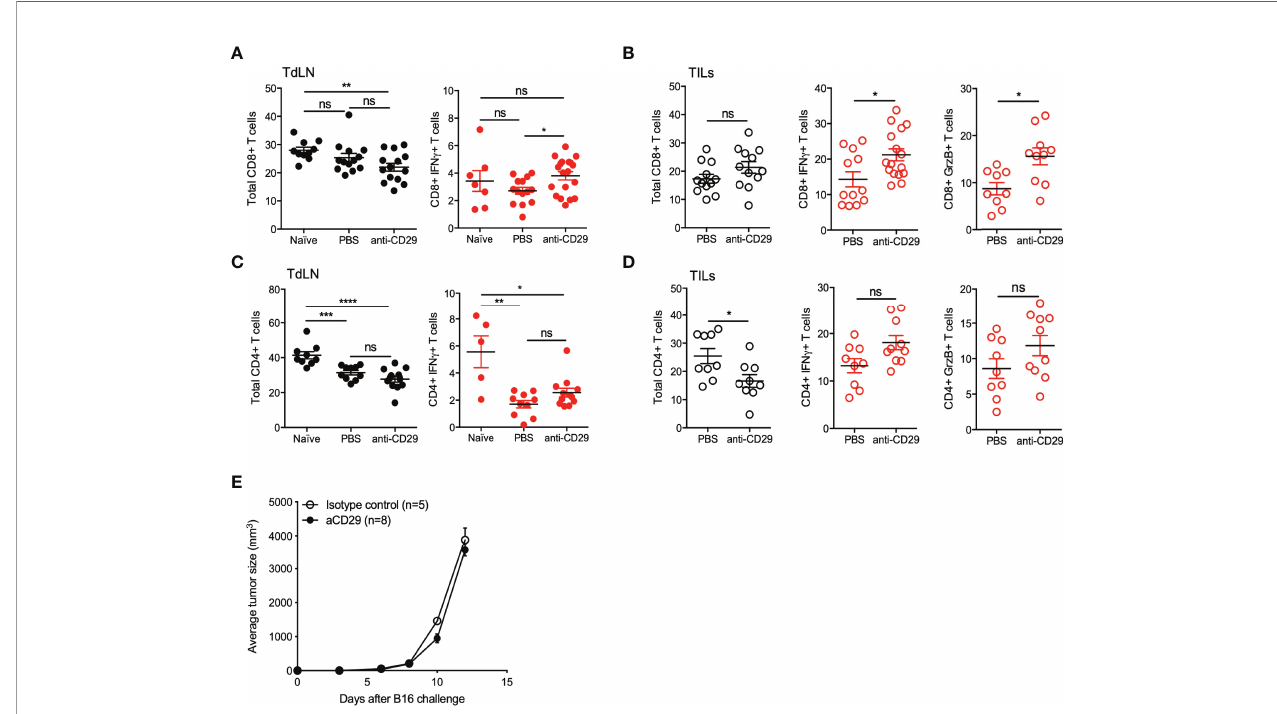
FIGURE 6 | Disruption of CD49b/CD29 axis triggers effector CD4+ T and CD8+ T cells function. A total of 2 × 10 5 B16 were injected into the right fl ank of C57BL6 GFP reporter mice. One hundred microliters of PBS 1× containing 200 ng of anti-CD29 antibody, or PBS alone as control, were administered to tumor- bearing animals when the tumors became palpable (approximately day 9 post-tumor inoculation). The treatment was given three times per week. At this time point, animals were euthanized for the isolation of TdLNs and tumors, and cell suspensions were processed for antibody staining using anti-CD4, anti-CD8, anti-CD49b, anti-IFN- g , and anti-granzyme B (GrzB). Further analysis was performed using fl ow cytometry, gating out cTreg and Tr1-like cells. The fi gure shows graphs depicting the frequencies of total CD8+ T cells and CD8+IFN- g + T cells in TdLN (A) , and total CD8+ T cells, CD8+IFN- g + T cells, and CD8+GrzB+ T cells in TILs (B) . The same analysis was performed for the CD4+ T cell compartment, in which total CD4+ T cells and CD4+IFN- g + T cells in TdLN (C) and total CD4+ T cells, CD4+IFN- g + T cells, and CD4+GrzB+ T cells in TILs (D) are shown. Data from three independent experiments are shown as the mean ± SEM. n = 3 – 6 mice per experiment. * p < 0.05; ** p< 0.01; *** p < 0.001; **** p< 0.0001; ns, not signi fi cant according to one-way ANOVA (multiple comparison) for panels (A, C) and Mann – Whitney test (for panels B, D ). (E) RAG-KO mice inoculated with 10 5 B16 melanoma cells and treated as